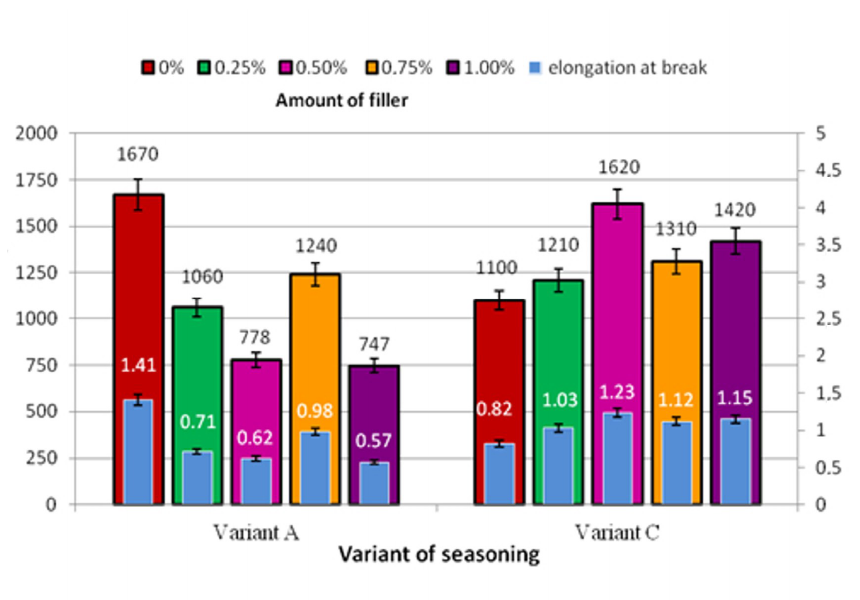
Figure 6. Maximum force and elongation at break of adhesive joints produced according to Methods I and including Variant A and Variant C